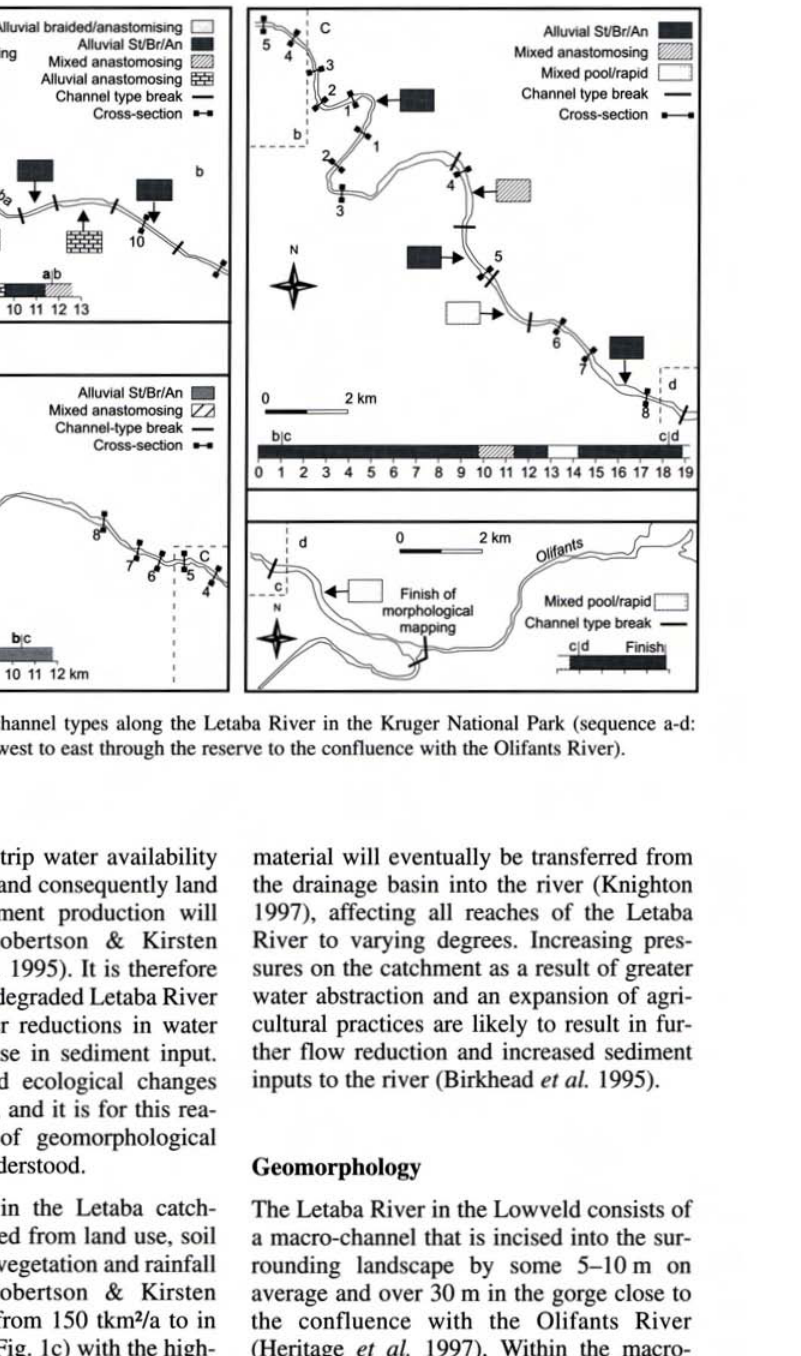
1990b). Yields range from 150 tkm 2 /a to in excess of 400 tkm1/a (Fig. I c) with the high est yields occuning in the densely populated rural areas in the west of the catchment.